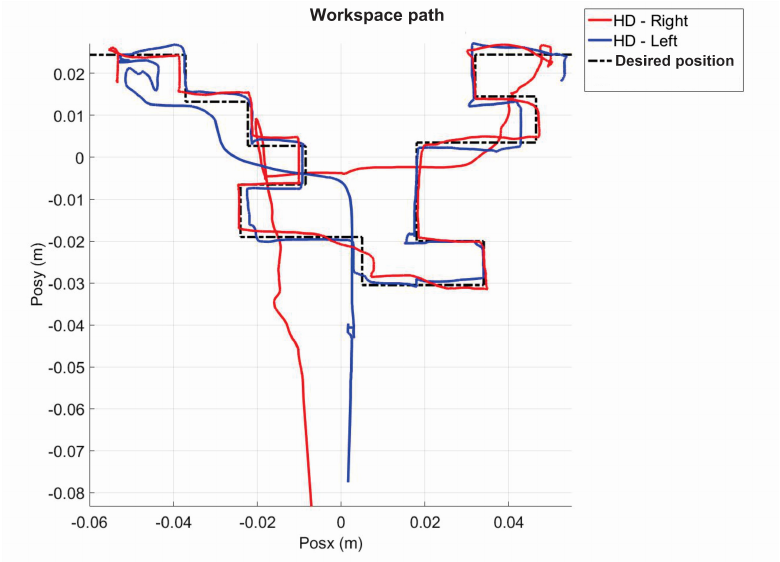
Figure 25. Workspace trajectory of two haptic devices in active haptic guidance task: exercise 2.